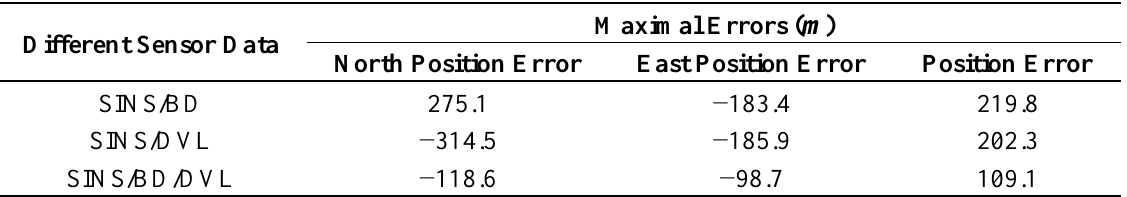
Table 2. Simulation Results with different sensor